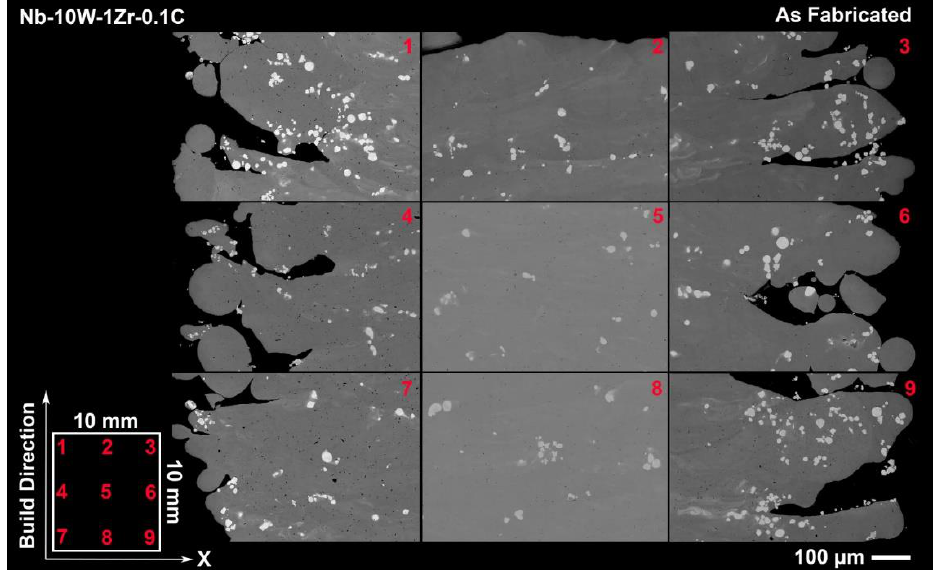
Figure 7. Tiled SEM image of as fabricated Nb-10W-1Zr-0.1C tensile sample witness cylinders depicting spatial microstructural variations.